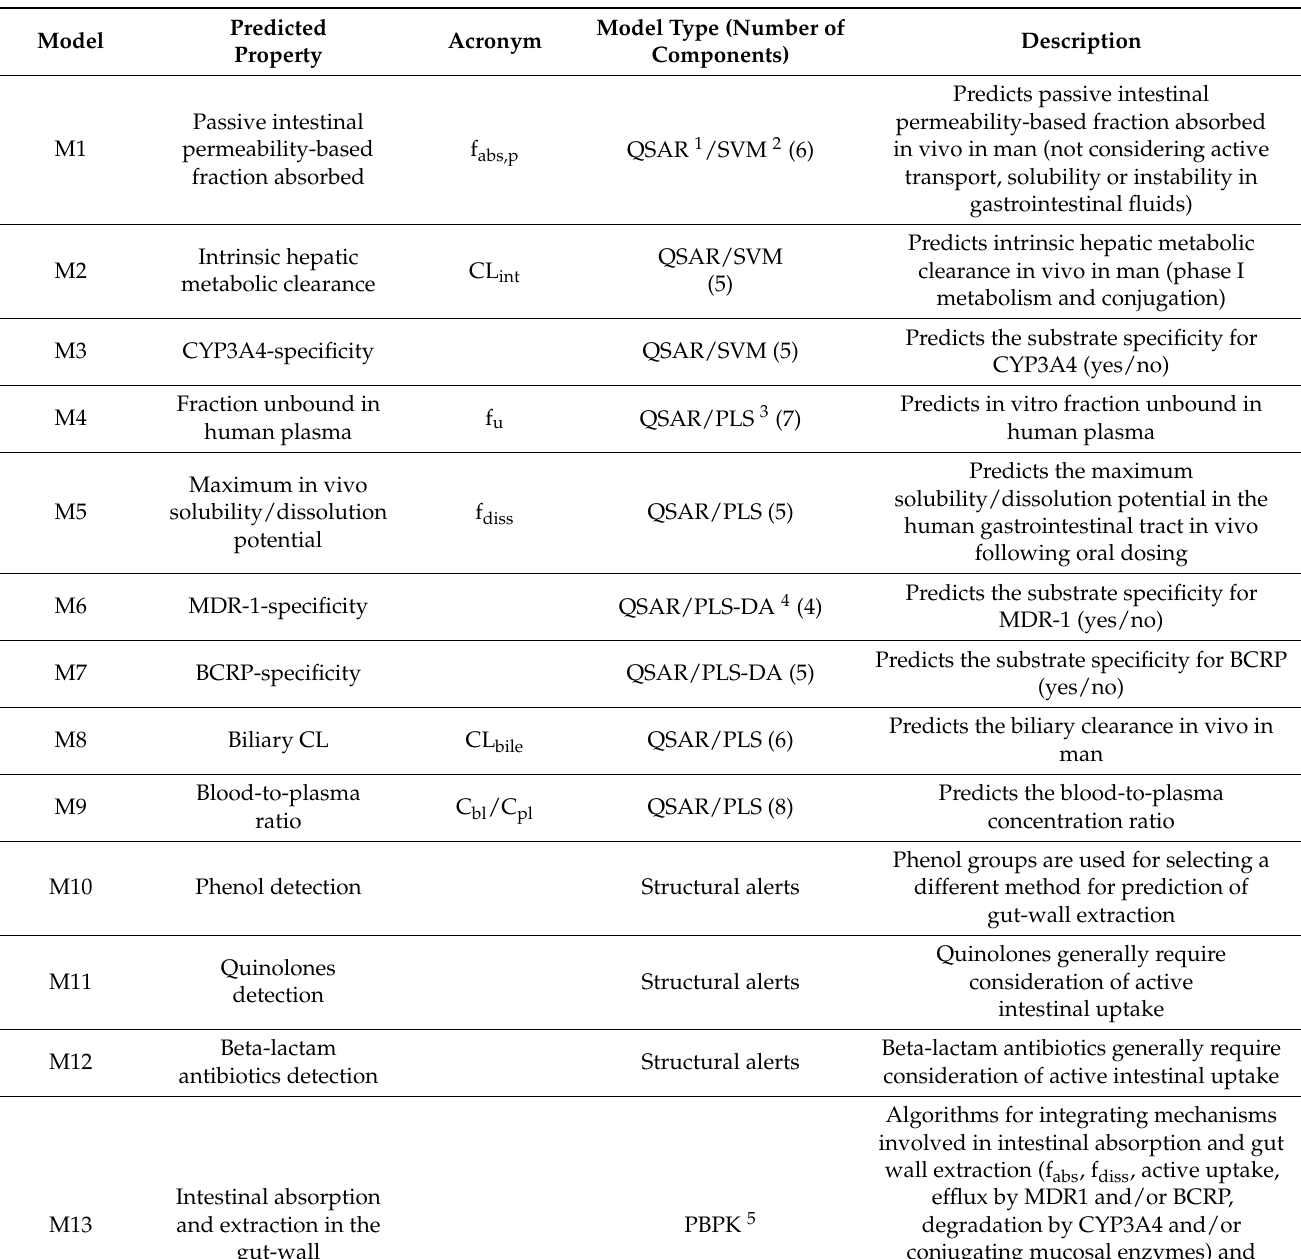
Table 2. The 14 models and algorithms that were integrated to predict oral bioavailability in humans (F pred